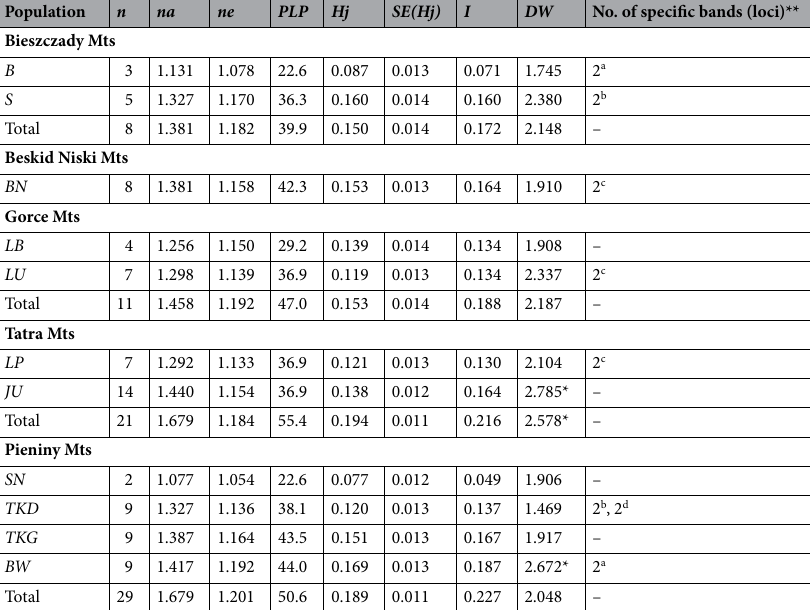
Table 3. Population genetic diversity of Gladiolus imbricatus in Western Carpathians and Eastern Carpathians (Bieszczady) and distribution of private and inter-regional specific bands based on 167 ISSR products. DW rarity index corresponding to “frequency-down-weighted marker values” per population, Hj Nei’s gene diversity, SE(Hj) standard error of Hj , I Shannon’s information index, n sampling size, na observed no. of alleles, ne effective no. of alleles, PLP percentage of polymorphic loci. See also Table 1. *Significantly (p < 0.05) higher value based on 999 permutations. **The same letter denotes common occurrence of the same bands in various